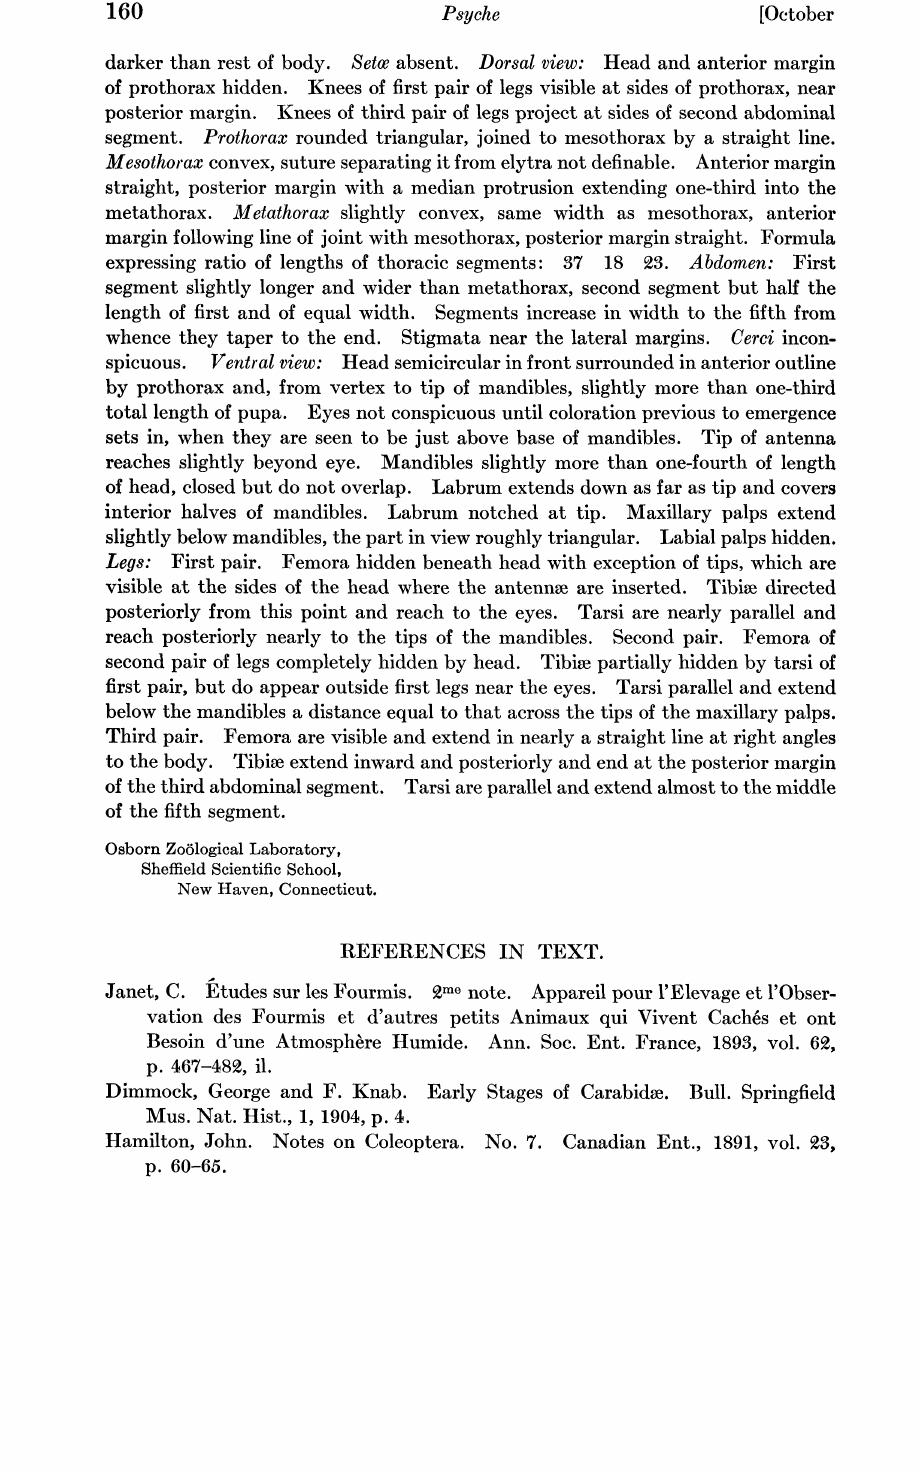
darker than rest of body. Setoe absent. Dorsal view: Head and anterior margin of prothorax hidden. Knees of first pair of legs visible at sides of prothorax, near posterior margin. Knees of third pair of legs project at sides of second abdominal segment. Prothorax rounded triangular, joined to mesothorax by a straight line. Mesothorax convex, suture separating it from elytra not definable. Anterior margin straight, posterior margin with a median protrusion extending one-third into the metathorax. Metathorax slightly convex, same width as mesothorax, anterior margin following line of joint with mesothorax, posterior margin straight. Formula expressing ratio of lengths of thoracic segments: 37 18 3. Abdomen: First segment slightly longer and wider than metathorax, second segment but half the length of first and of equal width. Segments increase in width to the fifth from whence they taper to the end. Stigmata near the lateral margins. Cerci incon- spicuous. Ventral view: Head semicircular in front surrounded in anterior outline by prothorax and, from vertex to tip of mandibles, slightly more than one-third total length of pupa. Eyes not conspicuous until coloration previous to emergence sets in, when they are seen to be just above base of mandibles. Tip of antenna reaches slightly beyond eye. Mandibles slightly more than one-fourth of length of head, closed but do not overlap. Labrum extends down as far as tip and covers interior halves of mandibles. Labrum notched at tip. Maxillary palps extend slightly below mandibles, the part in view roughly triangular. Labial palps hidden. Legs: First pair. Femora hidden beneath head with exception of tips, which are visible at the sides of the head where the antennae are inserted. Tibim directed posteriorly from this point and reach to the eyes. Tarsi are nearly parallel and reach posteriorly nearly to the tips of the mandibles. Second pair. Femora of second pair of legs completely hidden by head. Tibiae partially hidden by tarsi of first pair, but do appear outside first legs near the eyes. Tarsi parallel and extend below the mandibles a distance equal to that across the tips of the maxillary palps. Third pair. Femora are visible and extend in nearly a straight line at right angles to the body. Tibiae extend inward and posteriorly and end at the posterior margin of the third abdominal segment. Tarsi are parallel and extend almost to the middle of the fifth